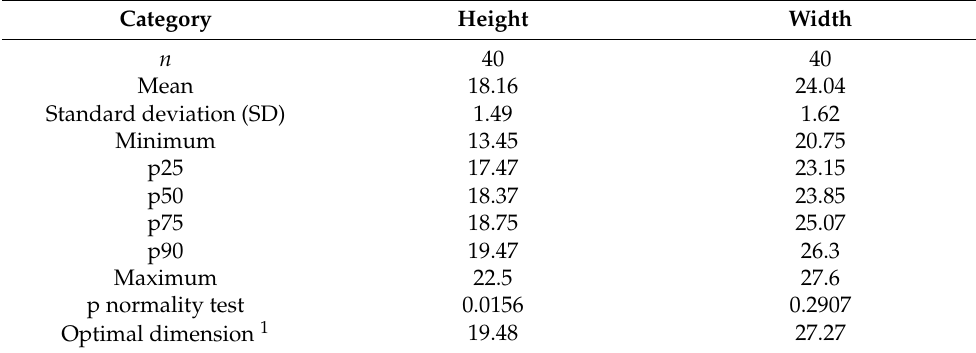
Table 1. Radiographic tooth measurements and suitable dimensions of the radiographic plate.